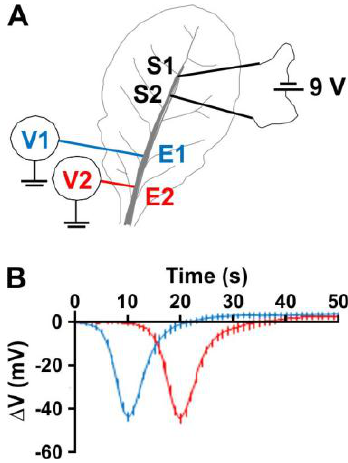
Figure 1. Action potentials directly recorded in Arabidopsis leaves. ( A ) Scheme of the experimental setup. ( B ) Time-course of averaged APs (voltage as a function of time) at electrodes E1 (blue) and E2 (red) recorded in the electrically-stimulated WS ecotype (Means ± SE, n = 25). Zero time: start of the 5-s electrical stimulation.